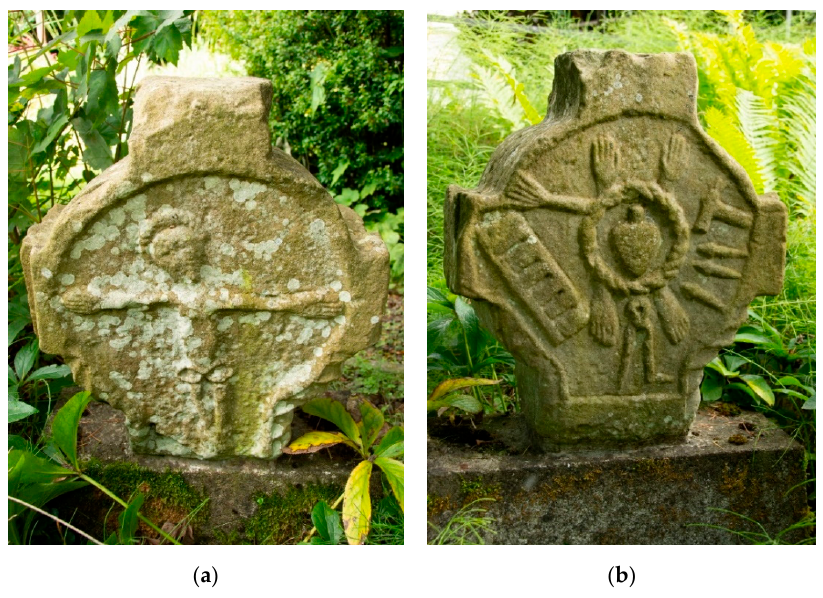
Figure 29. ( a ) Kilmore Churchyard Cross, now at the parish church of Moynalvey, Co. Meath, c.1575 south side, ( b ) north side. Photographs by the author.